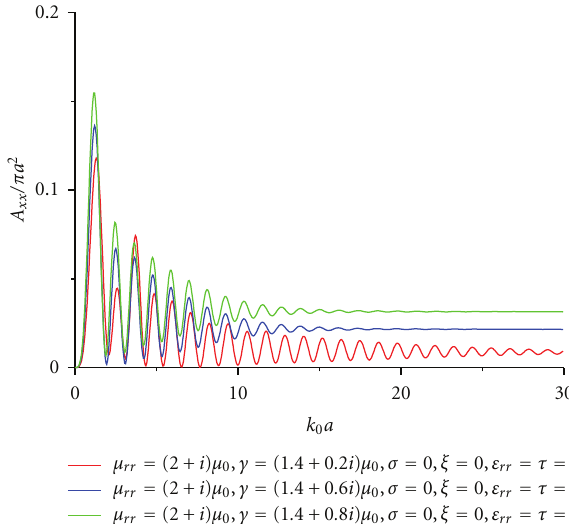
Figure 5: Normalized backscattering values versus sphere radius. Di ff erent positive anisotropic value influence is considered. Here, we reduce the positive values.